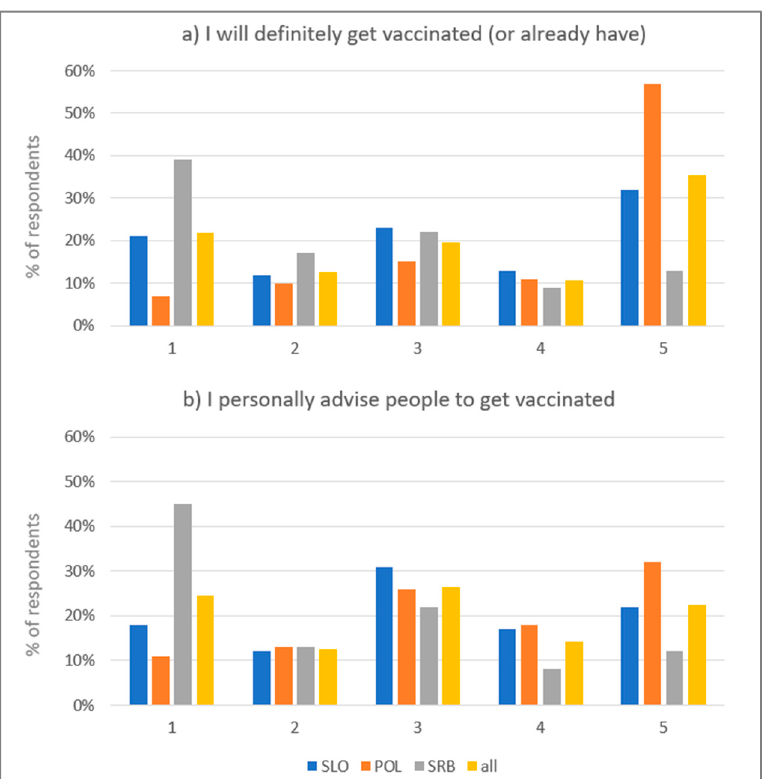
Figure 1. Percentage of respondents declaring different intentions regarding being vaccinated ( a ) and their engagement in advising people to be vaccinated ( b ) (1—I absolutely disagree; 5—I absolutely agree; SLO—Slovenia, POL—Poland, SRB—Serbia).